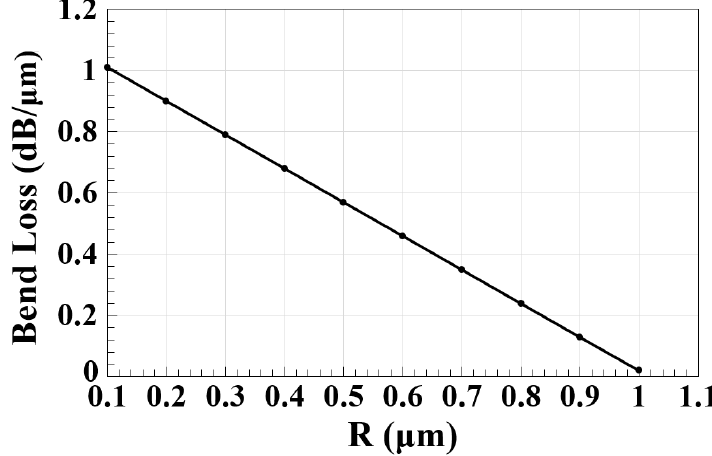
Figure 6. Bending radiation loss versus bend radius (R) utilizing 2 × 2 silicon waveguide at 1.55 µ m.